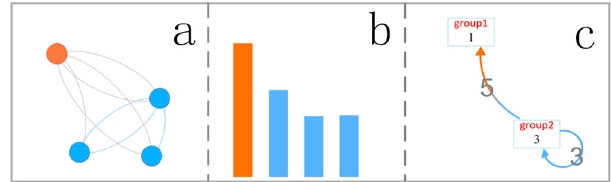
Figure 8. Sharing of underlying data for multi-view association analysis, ( a ) node-link diagrams; ( b ) histograms of degree; ( c ) interaction